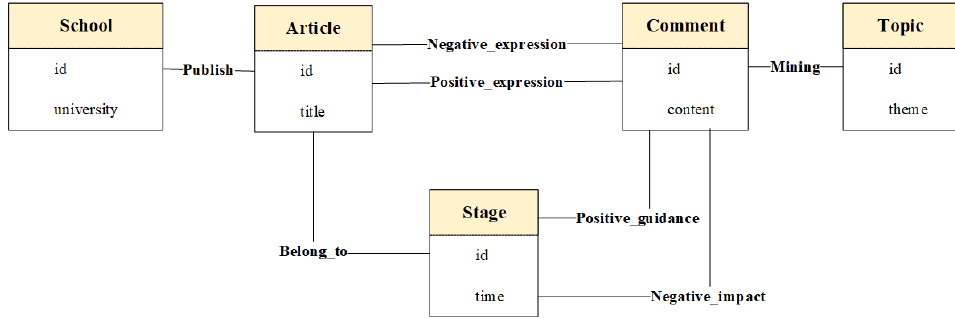
Figure 11. Neo4j database structure diagram.